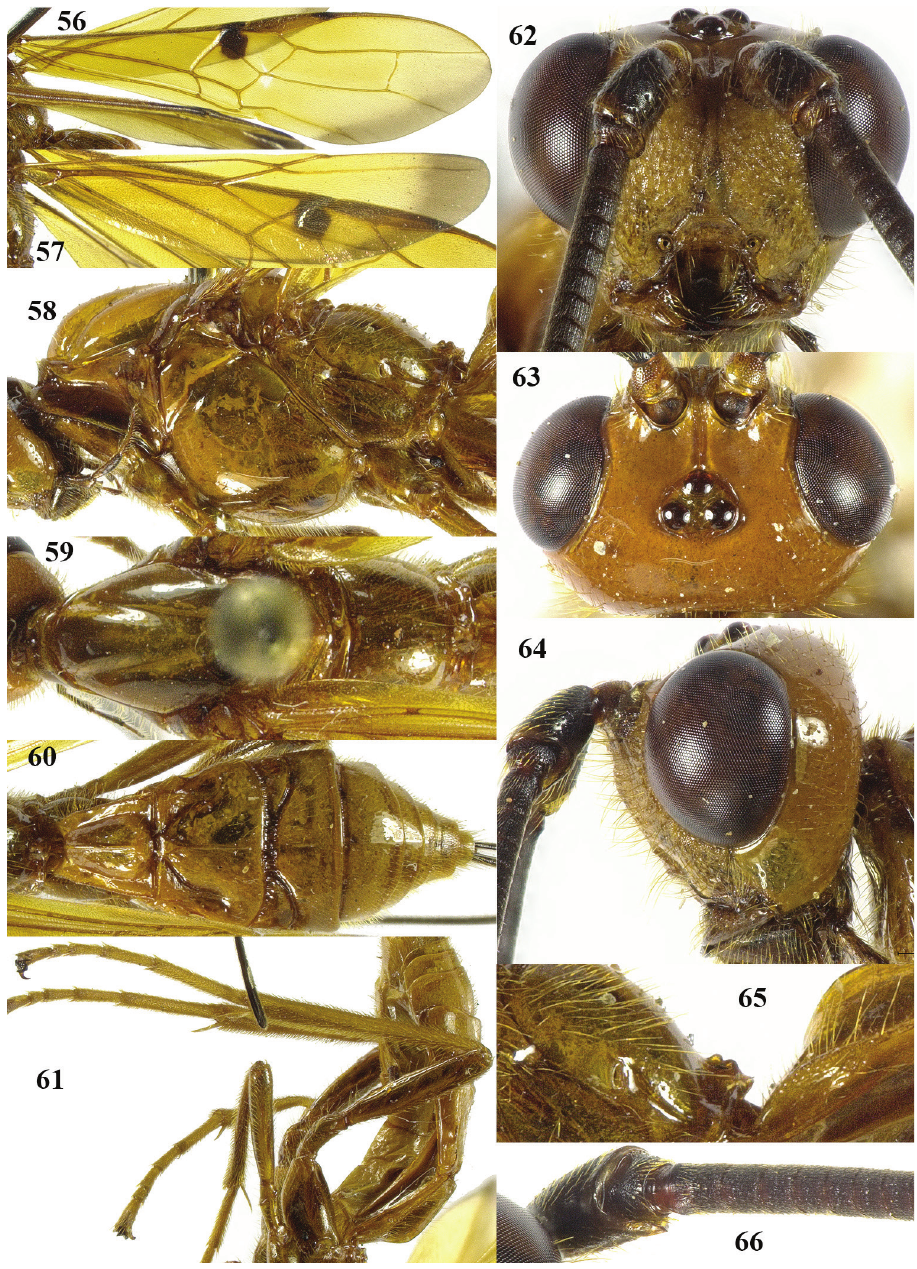
Figures 56–66. Maculibracon hei sp. n., ♀ , holotype. 56 fore wing 57 hind wing 58 mesosoma lateral 59 mesosoma dorsal 60 metasoma dorsal 61 hind leg lateral 62 head anterior 63 head dorsal 64 head lateral 65 propodeum lateral 66 scapus outer side